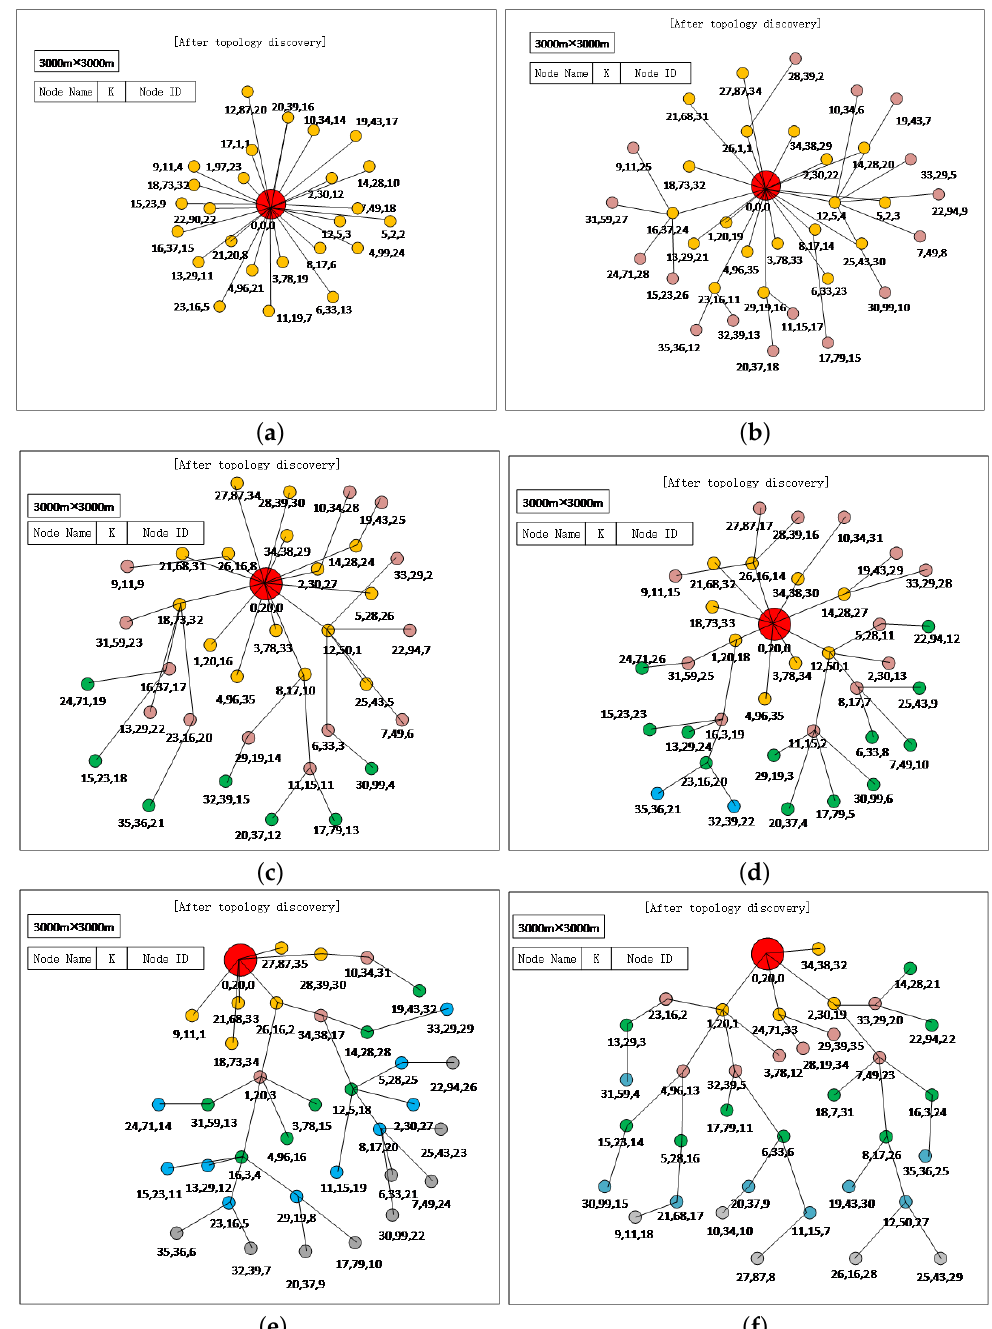
Figure 5. Acquired various network topology by the proposed ETDP protocol considering different node deployment: ( a ) Network layer is 1; ( b ) Network layer is 2; ( c ) Network layer is 3; ( d ) Network layer is 4; ( e , f ) Network layer is